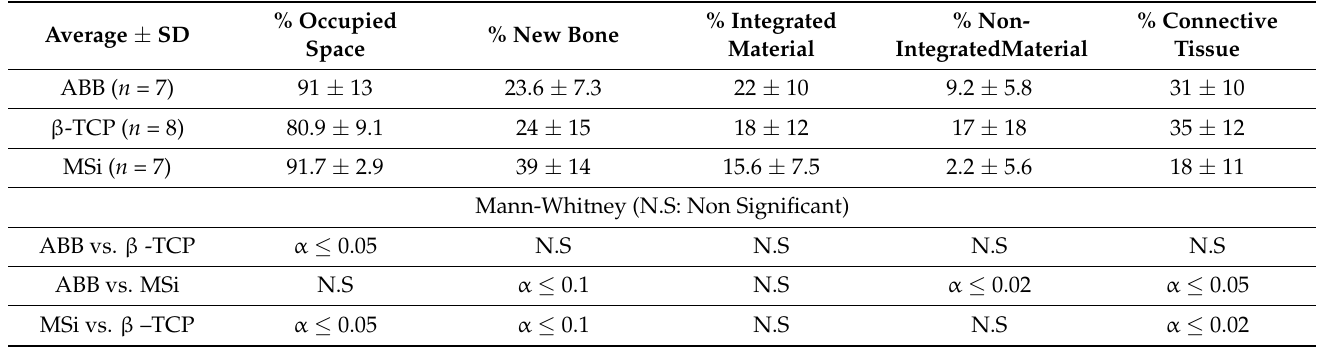
Table 1. Histomorphometric determinations and Mann-Whitney significance test. Average ± stan- dard deviations (SD) expressed as % of total cylinder volume for ABB, β -TCP and MSi. Significance was determined by the non-parametric two-tailed Mann-Whitney U test for the significance level: 90.